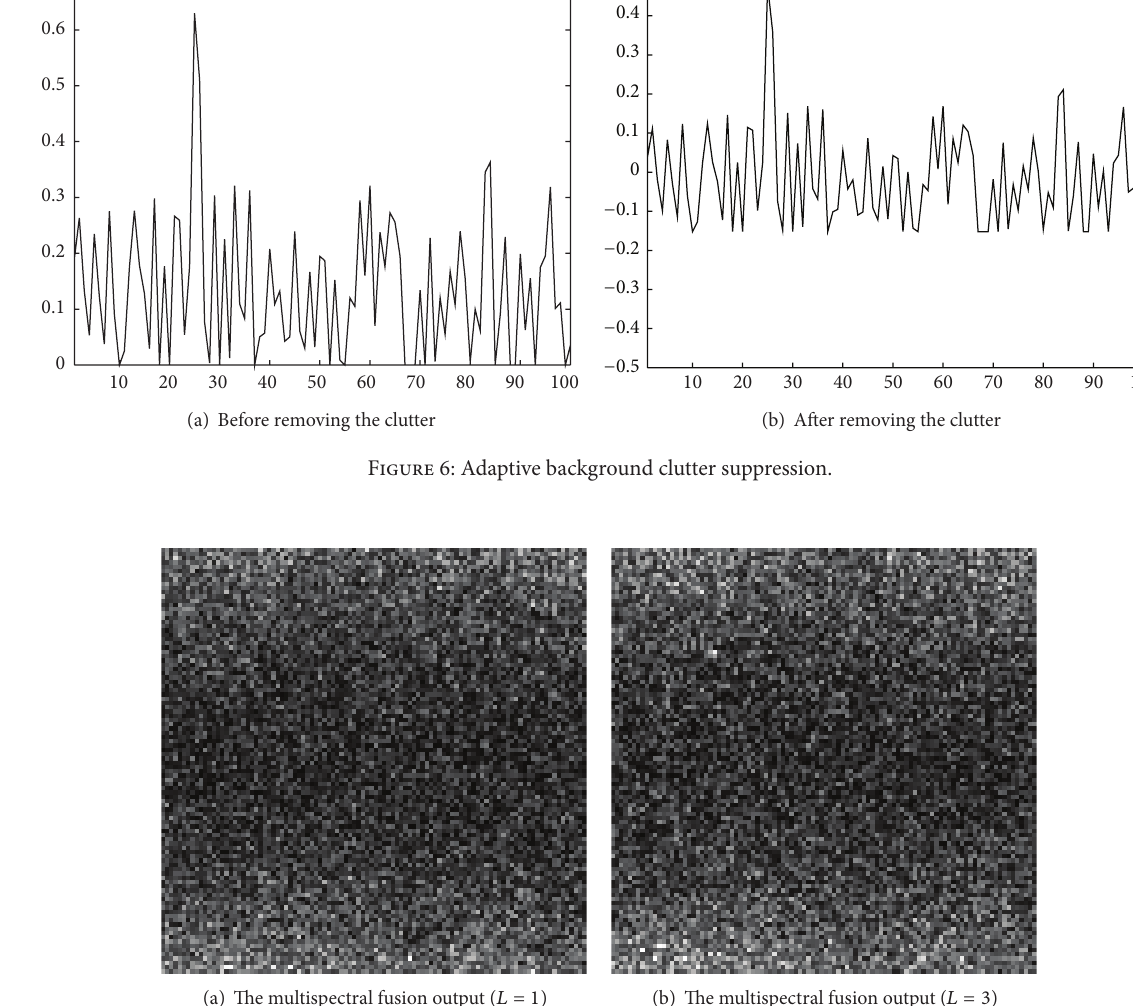
Figure 7: Multispectral fusion output using RX